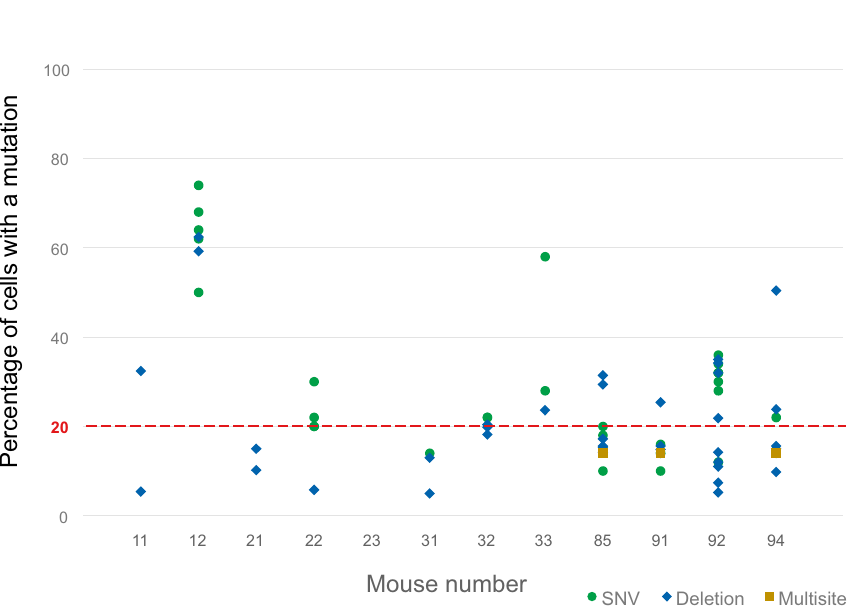
Figure 2. Clonal cell percentages in BM cells of irradiated mice. Cell percentages were estimated by doubling the VAFs of CH-associated mutations (N = 70, values are shown in Supplementary Table S1) in the BM because a somatic mutation normally occurs in a chromosome of a diploid cell. A VAF of 0.1 is equivalent to 20% of the cells. Multisite mutations are clustered SNVs and insertions/deletions. BM, bone marrow; CH, clonal hematopoiesis; SNV, single-nucleotide variant; VAF, variant allele